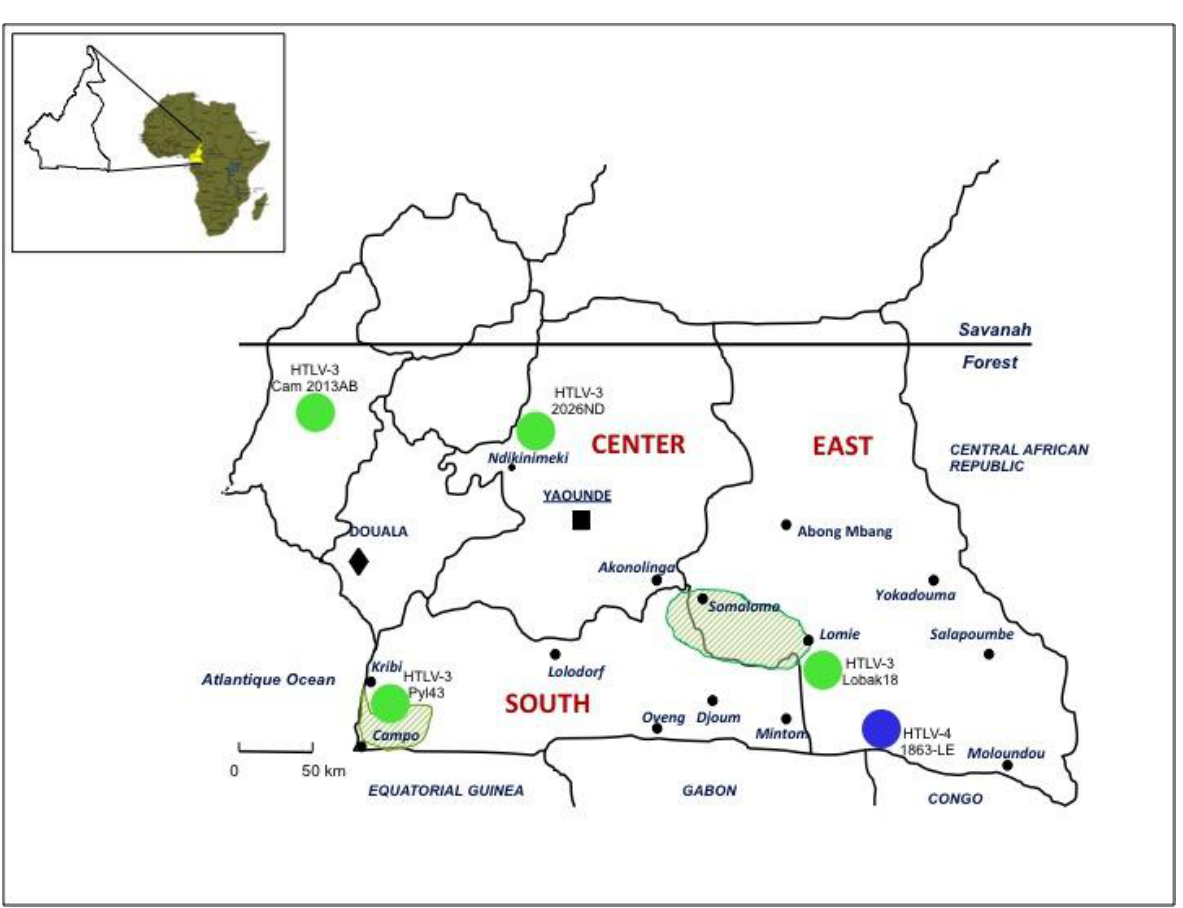
Figure 3. Geographical distribution of the four HTLV-3 and the unique HTLV-4 viruses reported in Cameroon. These viruses originated from individuals (either Pygmies or Bantus) living in villages or settlements of the rainforest of South Cameroon. This area is a region of high diversity for NHPs, many of them being infected by different STLV-1 and/or 3 viruses. The different human isolates are indicated with either a green circle (HTLV-3) or in blue (HTLV-4). The two shaded areas correspond to two nature reserves, the habitat of a large variety of non-human